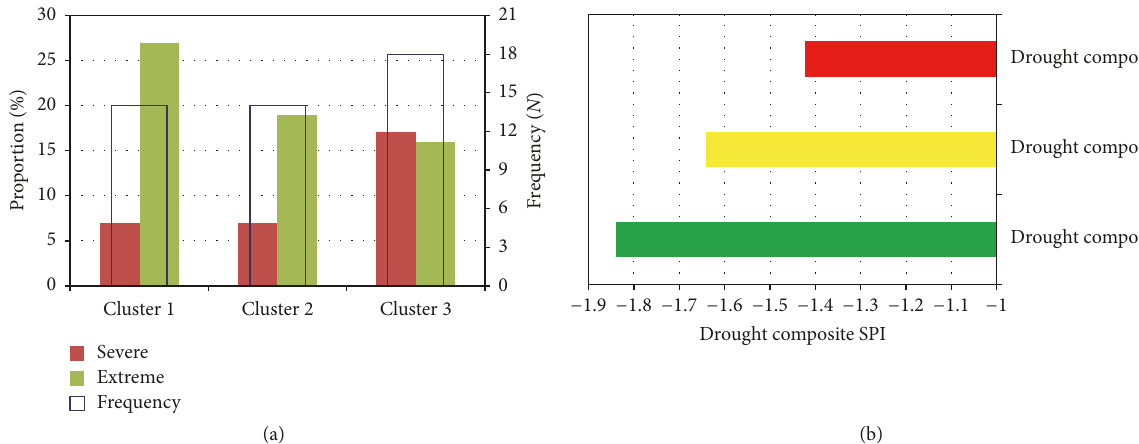
Figure 4: (a) Proportion of severe (extreme) droughts to total drought frequencies (SPI ≤ 0.524) and (b) composite SPIs for Clusters 1, 2, and 3 during the OND subseason. The composite years are 1965, 1972, 1990, 1994, and 1997.